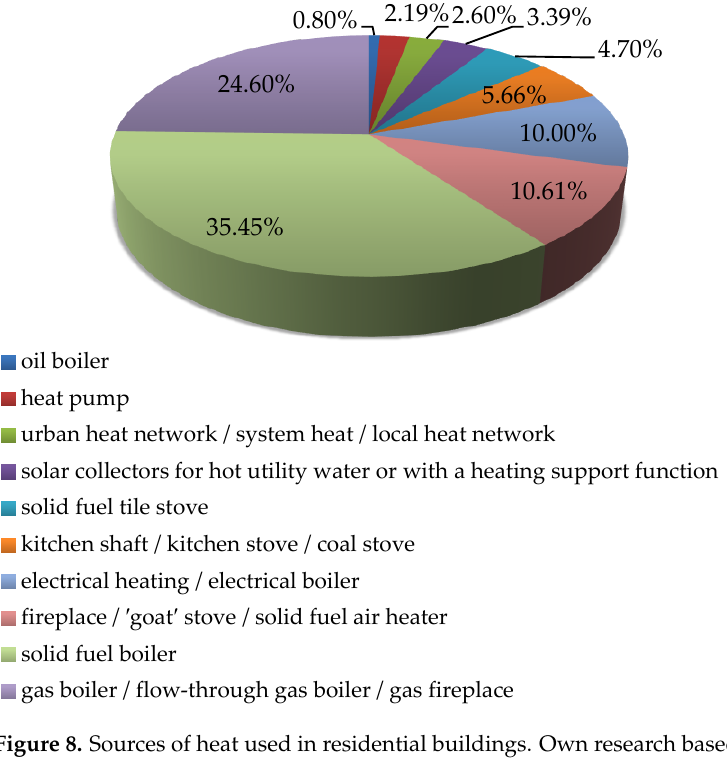
The detailed profile of the sample is presented in Table 1.